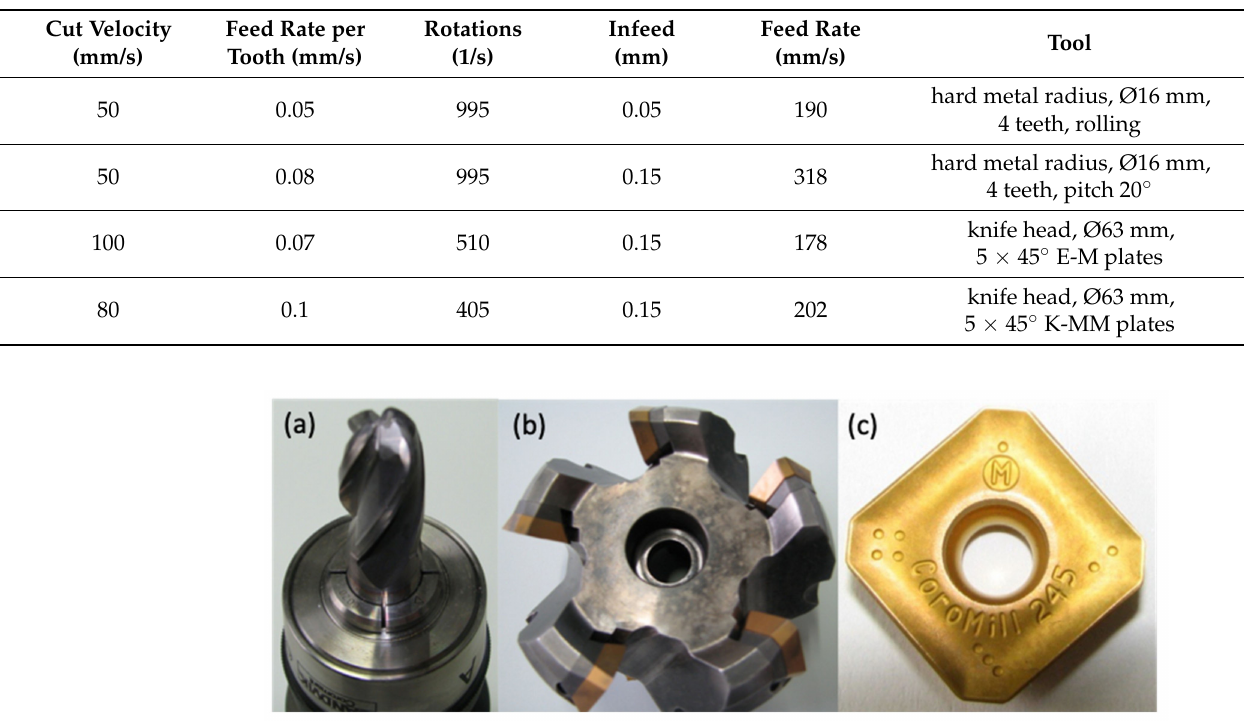
Figure 22. ( a ) 4 teeth radius cutter used for procedure # 1 and # 2; ( b ) 5 teeth knife head with ( c ) Sandvik cutter plates 1025 R245-12 T3 E-M and 2040 R245-12 T3 K-MM, used for procedure # 3 and # 4.